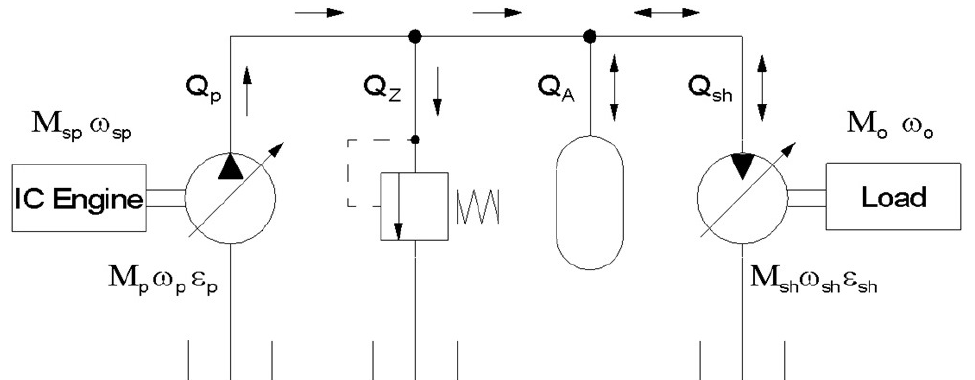
Figure 5. Diagram of multisource hydrostatic drive system ( M : torque; ω : angular velocity; Q : flow ratio; (cid:101) : hydrostatic unit control; indexes: sp : IC engine; p : hydrostatic pump; sh : hydrostatic motor; o : load; z : flow through overflow valve; A : hydraulic accumulator) [2].